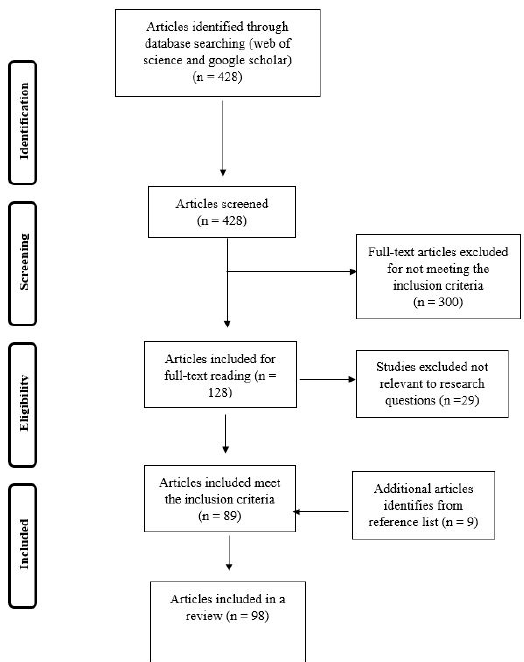
Figure 1. Flow chart of the study selection process for systematic review of the nutritional composition of edible insects.